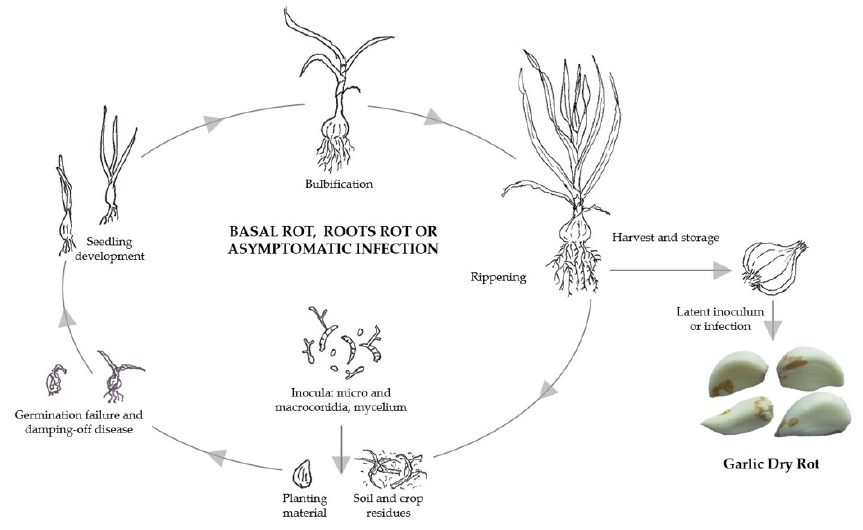
Figure 4. Disease cycle of garlic dry rot caused by Fusarium proliferatum